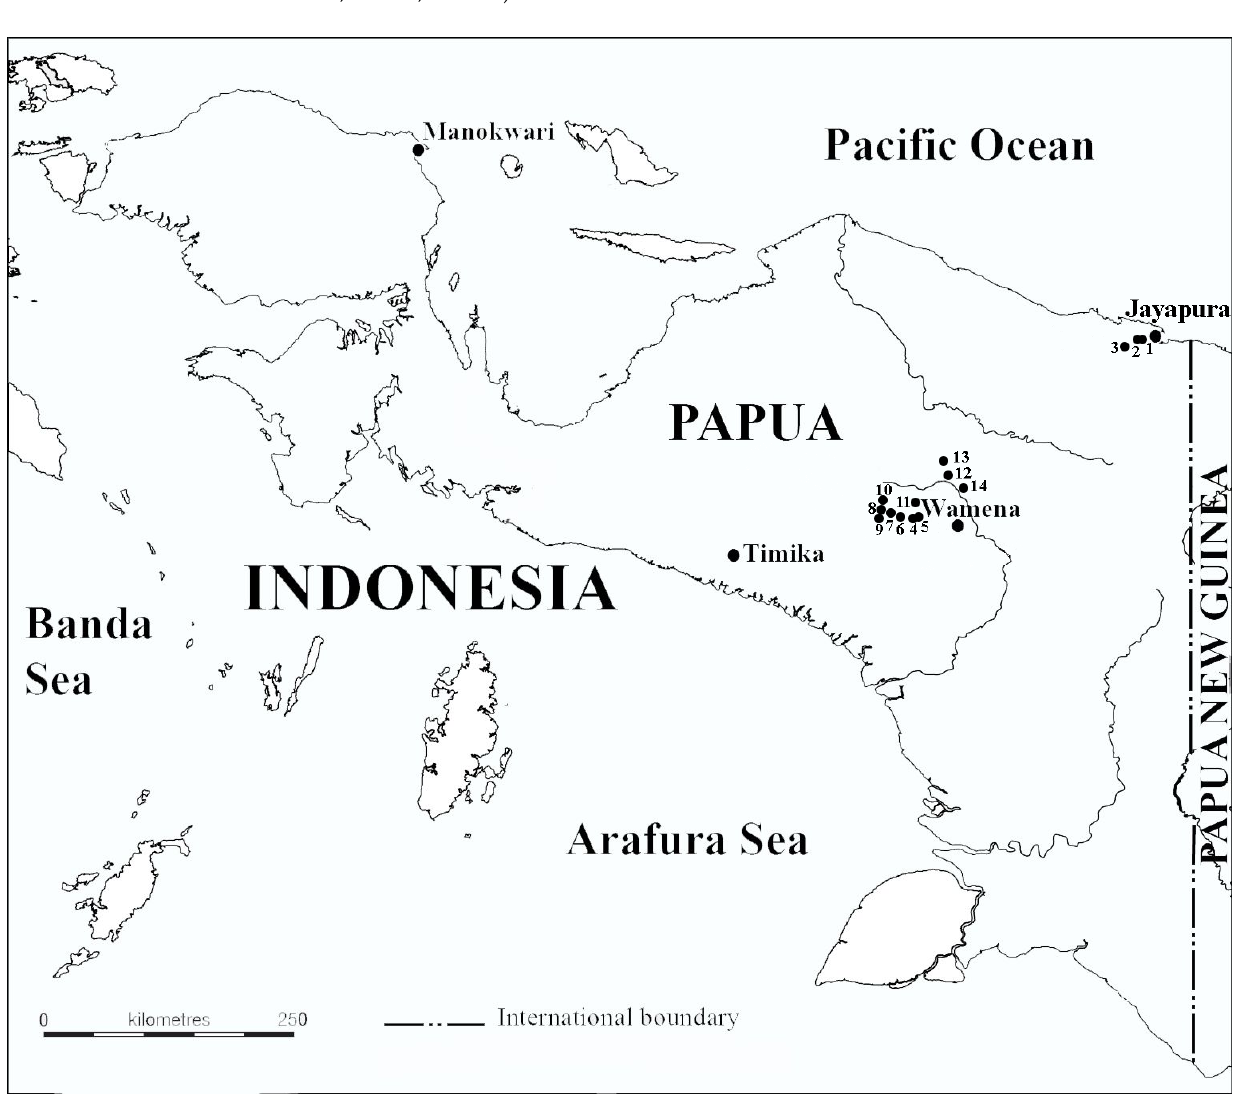
Figure 1. Map of the study area (dots indicate sampling sites).